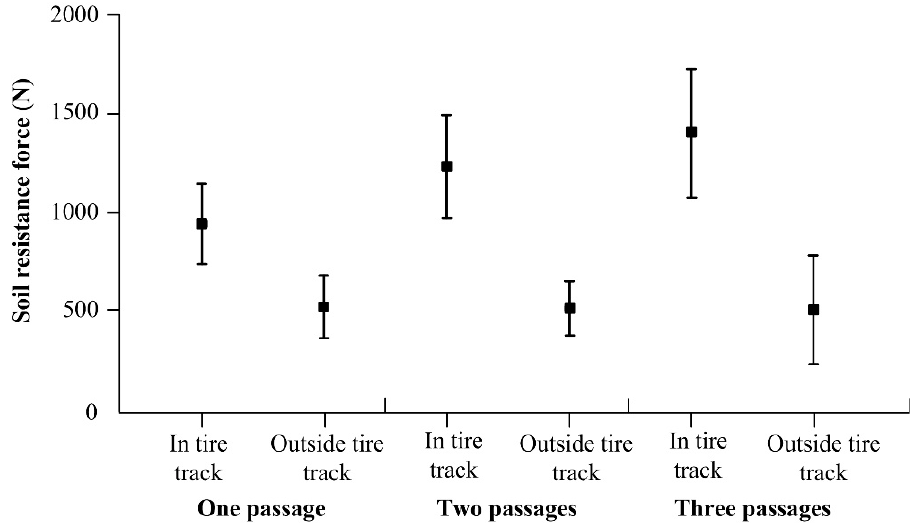
Figure 15. Statistical differences among data measured by the SRSF.